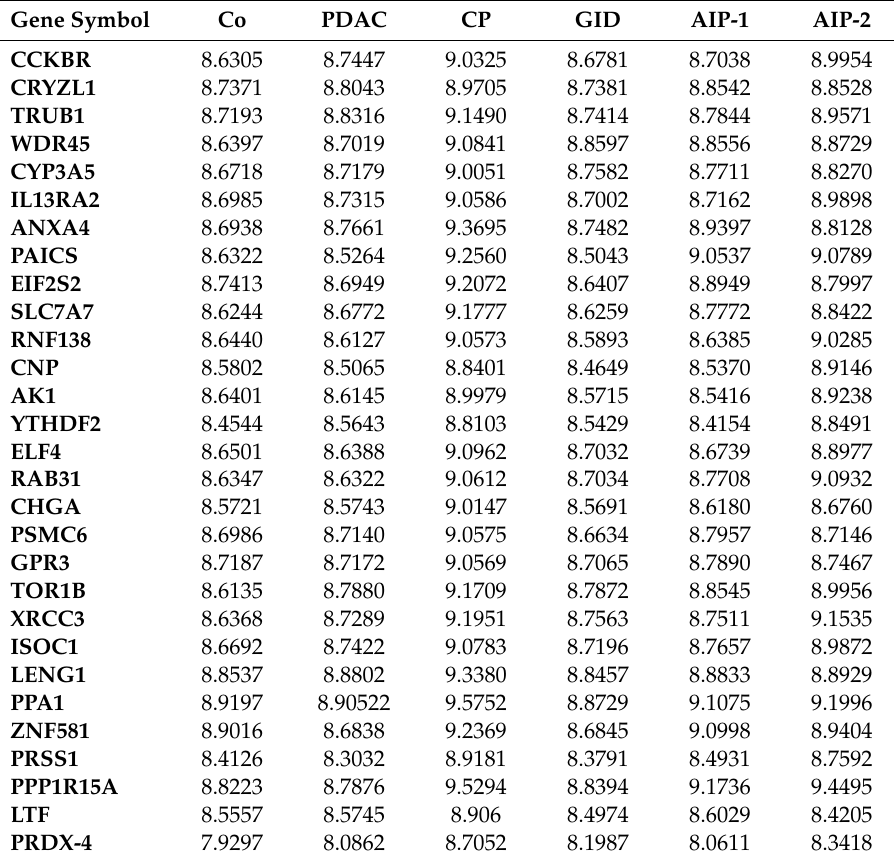
Table 3. Selected autoantigens and their normalized autoantibody levels (log2 of median fluorescence intensity) for all compared